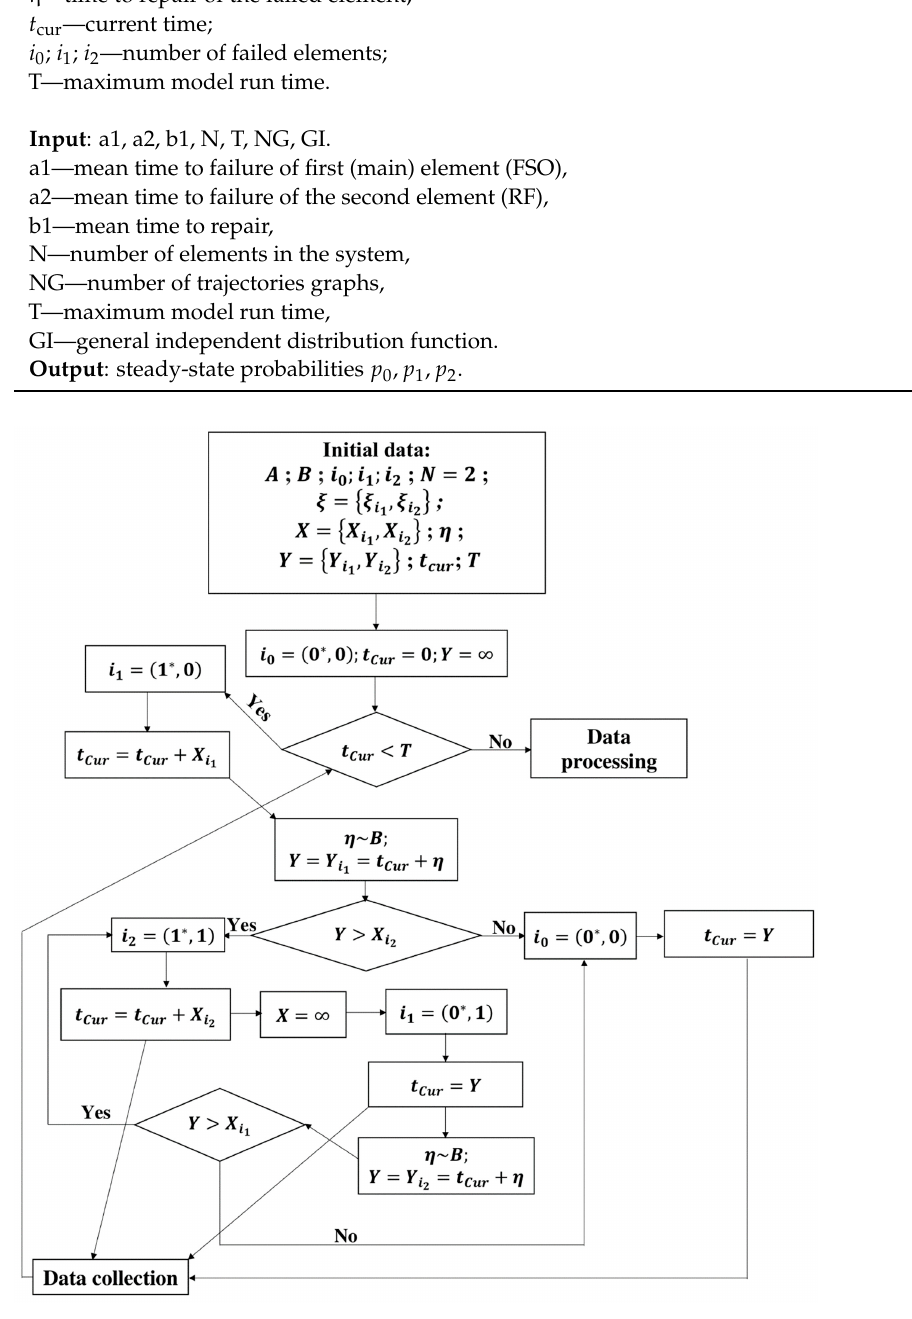
Figure 2. Block diagram of the simulation model for assessing steady-state probabilities.